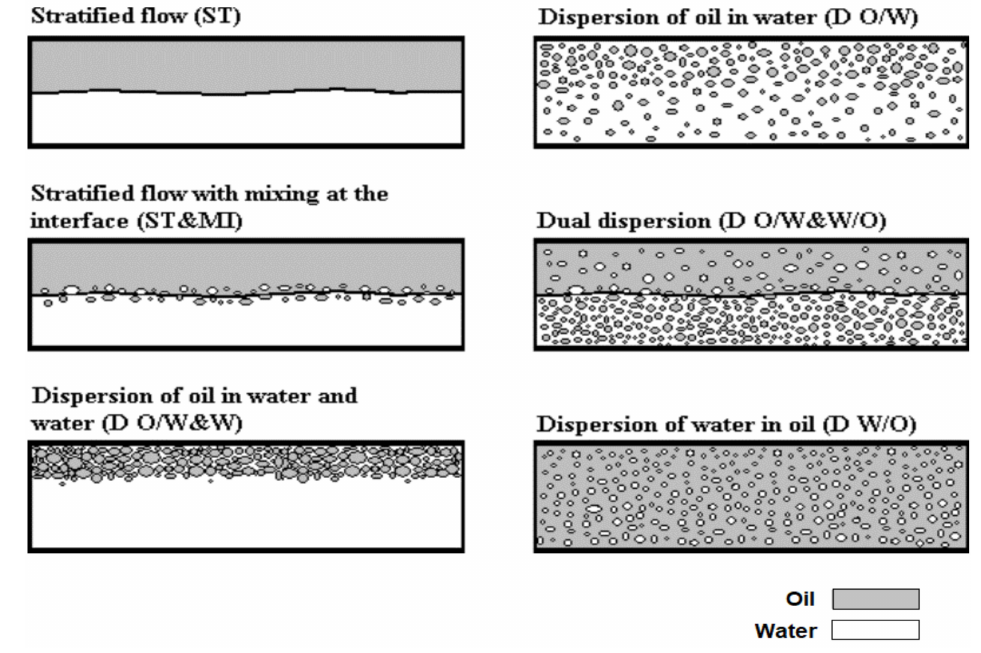
Figure 1. Flow pattern according to Trallero [6].